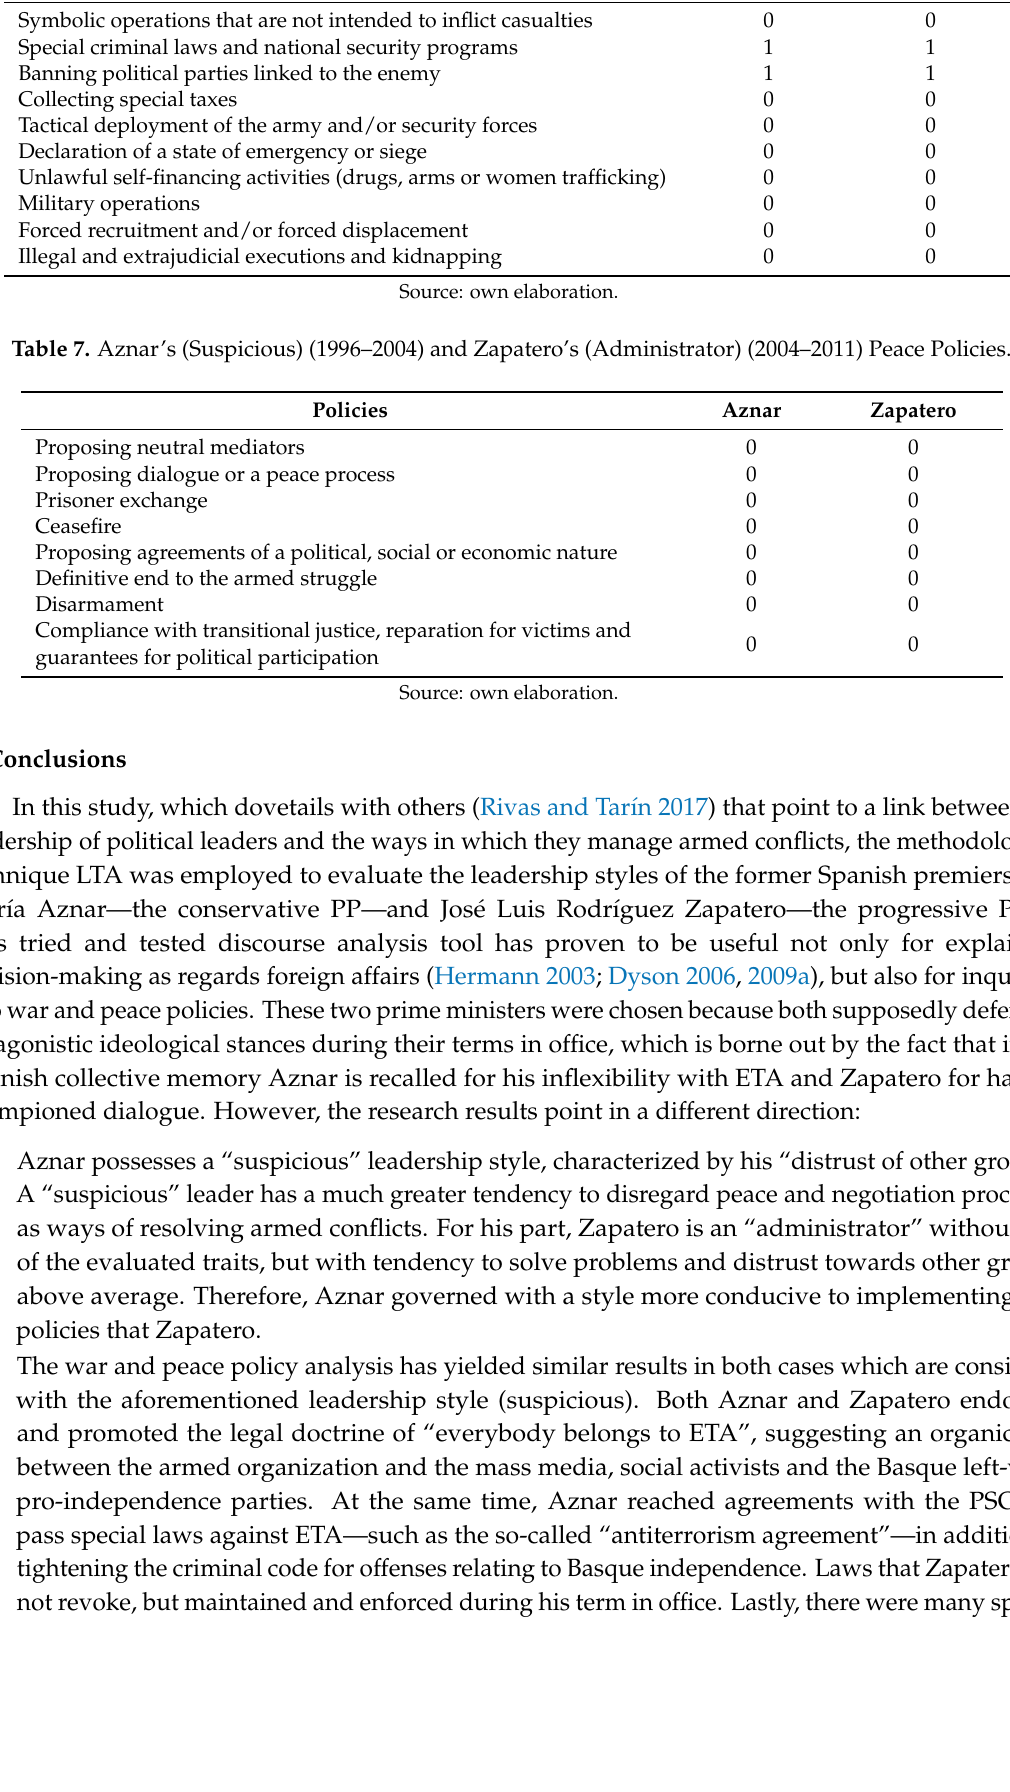
Table 6. Aznar’s (Suspicious) (1996–2004) and Zapatero’s (Administrator) (2004–2011) War Policies. Policies Aznar Zapatero Symbolic operations that are not intended to inflict casualties 0 0